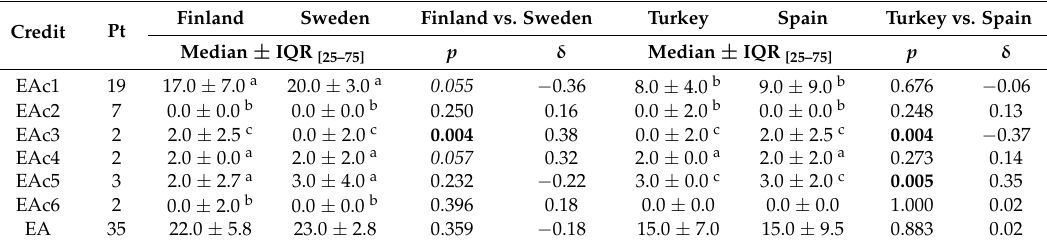
Table 5. EA achievement: Northern European countries vs. southern European